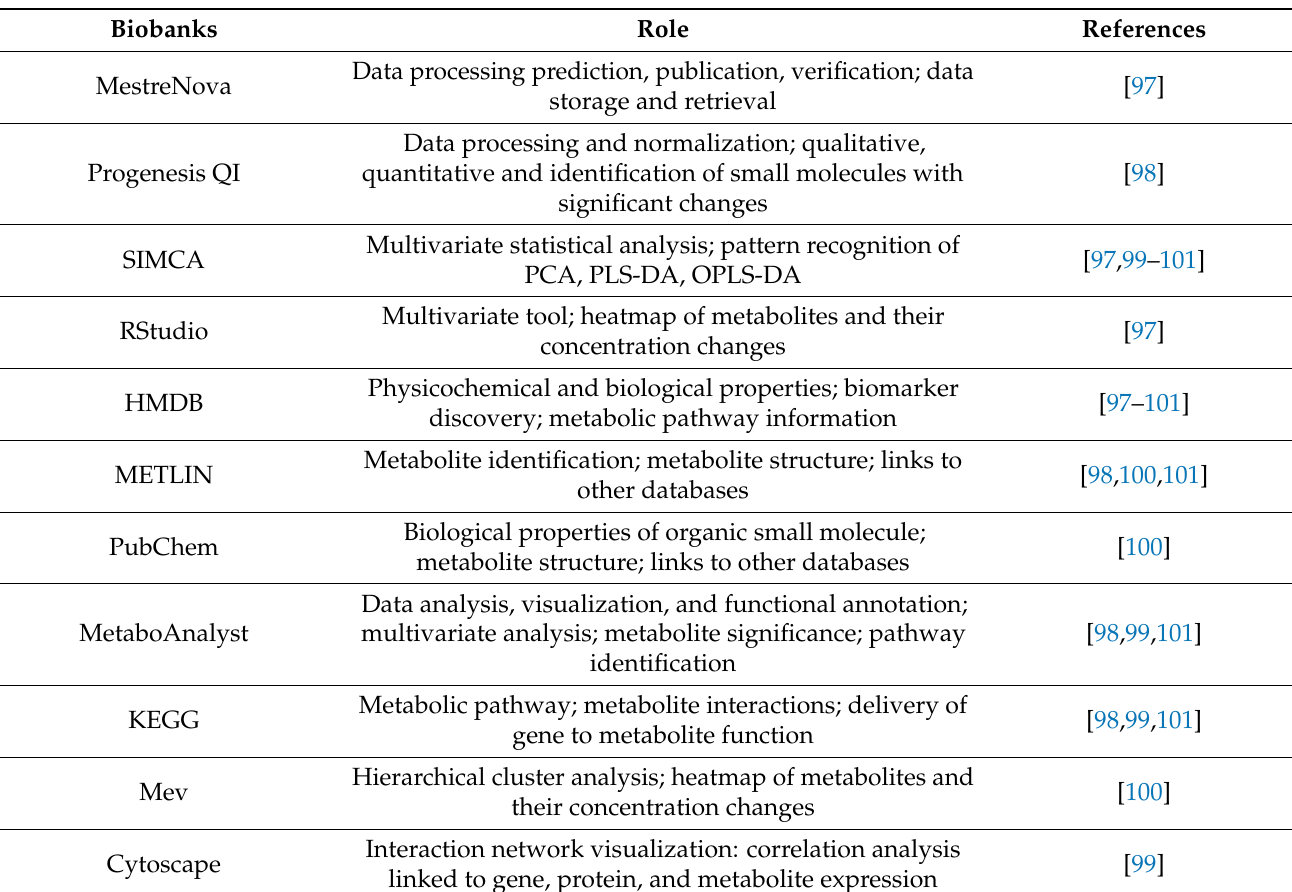
Table 1. Computational tools for metabolomics